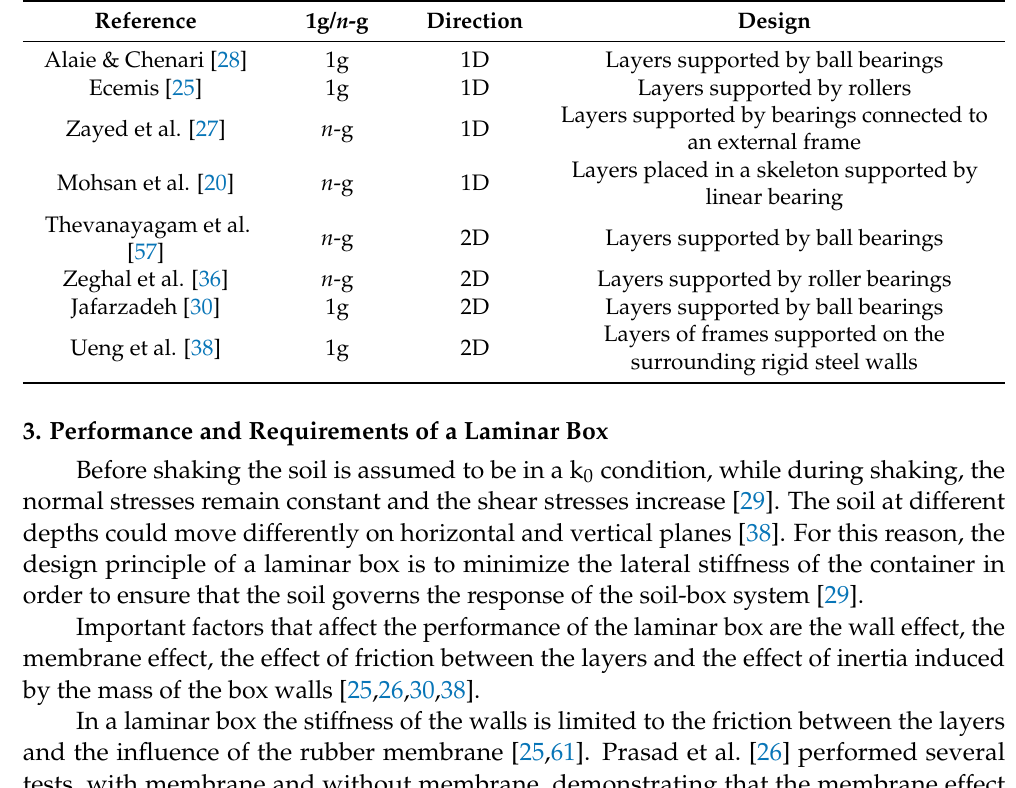
Table 1. Examples of laminar shear